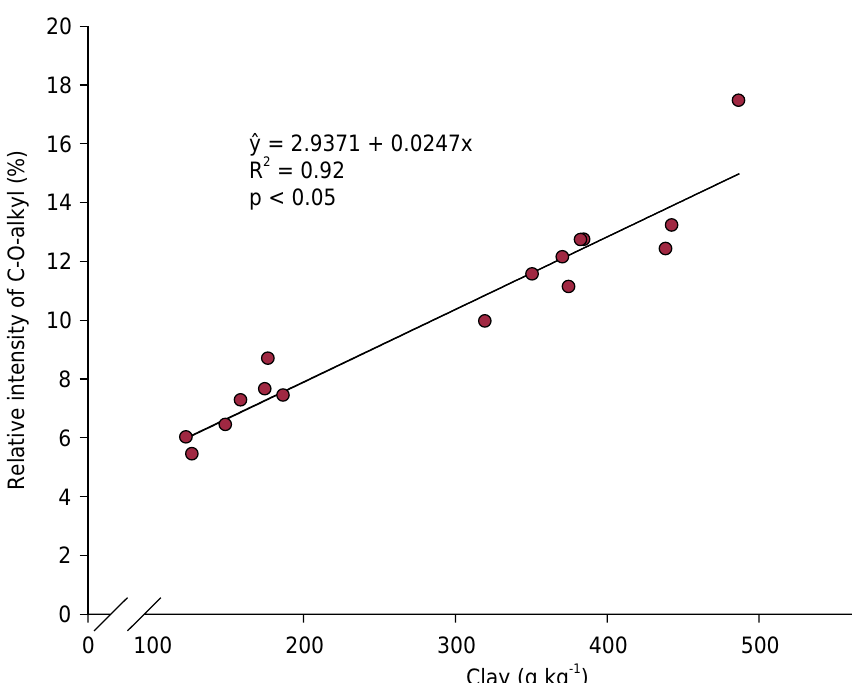
Figure 2. Linear regression between clay content and relative intensity of C-O-alkyl of FH and